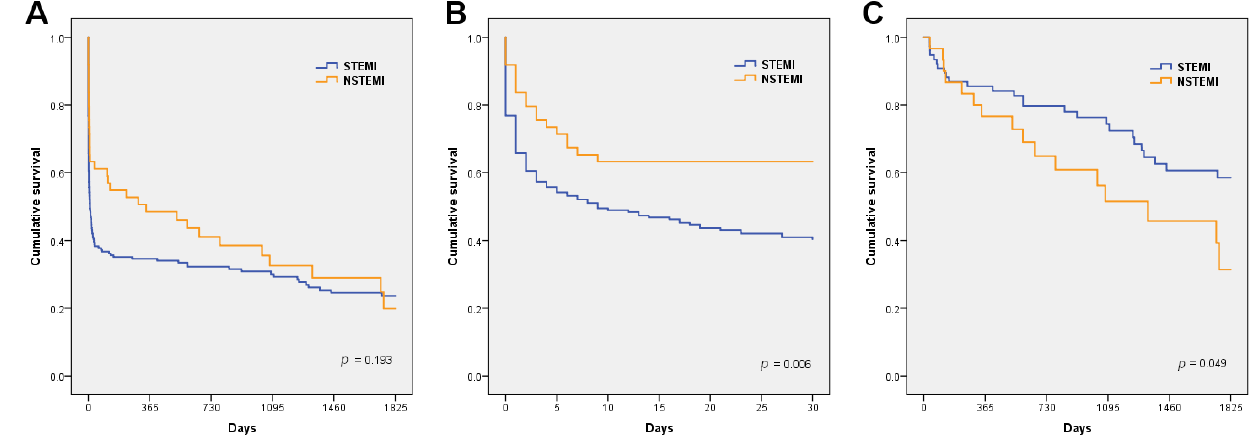
Figure 1. Kaplan–Meier curves according to ST-segment presentation showing non-adjusted cumulative survival. ( A ) All-cause death from admission to 5 years; ( B ) All-cause death in the first 30 days; ( C ) All-cause death from 30 days to 5 years. Table 4. Cox regression analyses of outcomes.